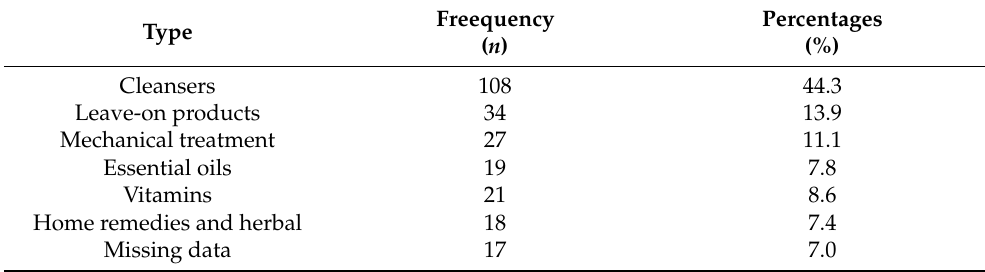
Table 4. Common types of over-the-counter acne treatments ( n =